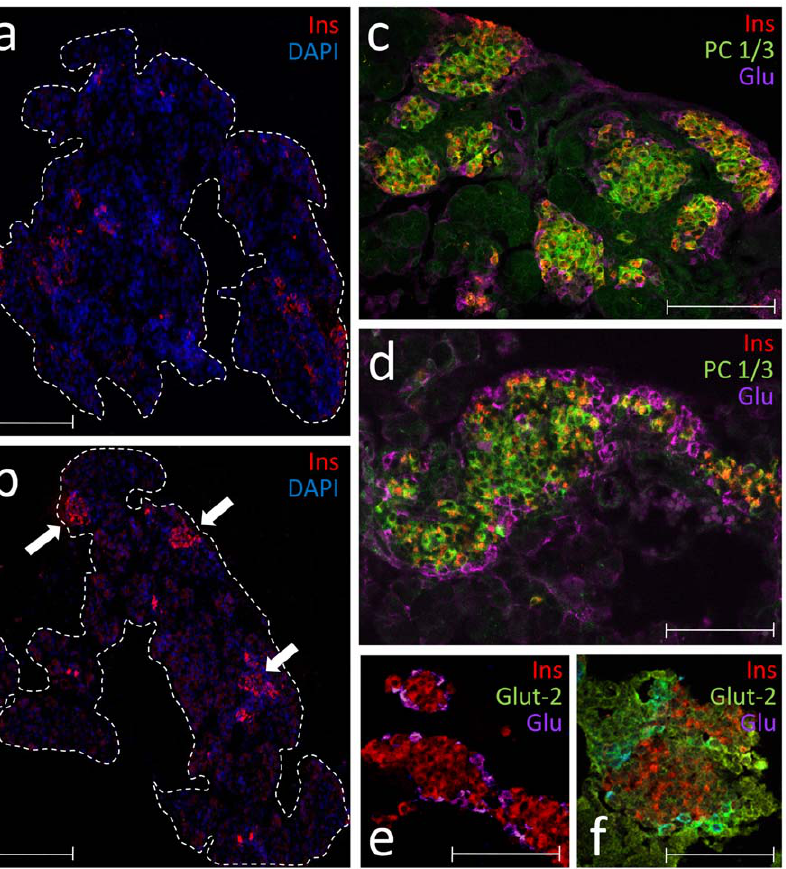
Figure 5. Histological analysis of TAT-MafA-treated pancreata in neonate pups. (A) Representative section of a control pancreas ( in utero injection: vehicle), showing a disorganized pattern of b cell expression (red) in islets. (B) Representative section of a pancreas of a neonate pup treated in utero with TAT-MafA. Islets are larger, rounder and more organized than in controls. Size bars: 500 m m. (C–D) High magnification confocal microphotograph of control neonatal (C) and TAT-MafA-treated (D) pancreata. While the former exhibits small islets in the process of coalescence, islets from the latter are already larger in size. Prohormone convertase (PC) 1/3 staining (green) was similar in both samples despite a trend in favor of the experimental group by qRT-PCR (fig. 4). Glucagon staining (purple) was stronger in (D) at the same exposure. Size bars: 75 m m. (E) Glut-2 staining (green) is not evident in control samples, but can be observed in TAT-MafA samples (F). Size bars: 75 m m.